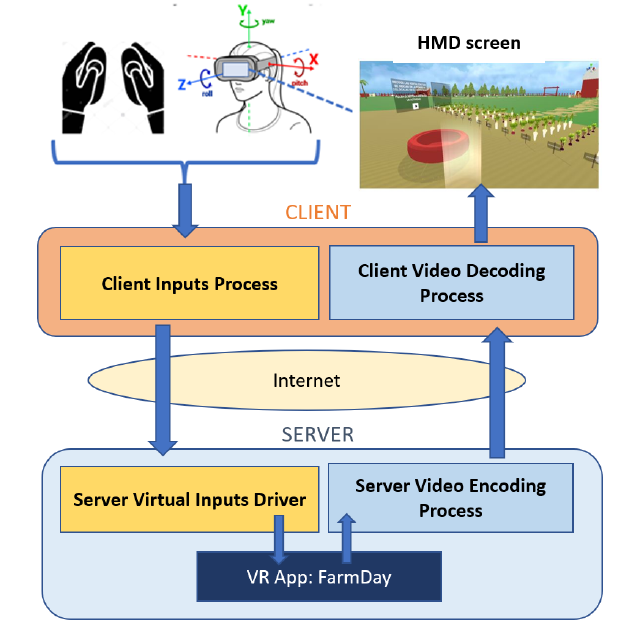
Figure 1. Diagram of the the real-time, remote VR system